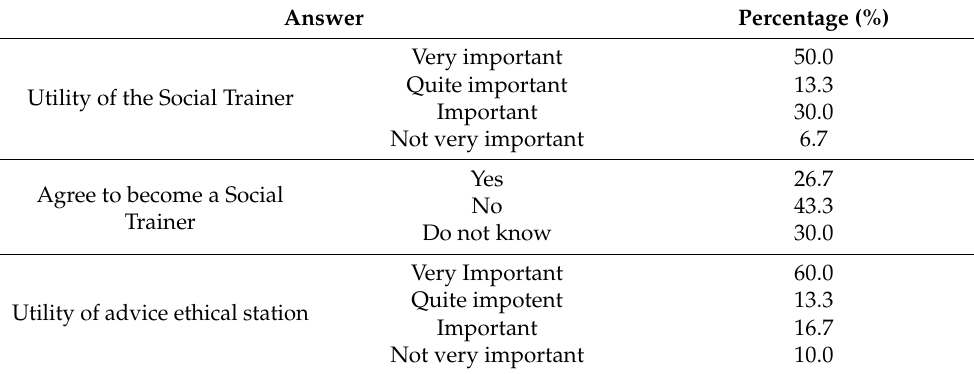
Table 4. Set of responses from the preliminary investigation that focused on the role of the Social